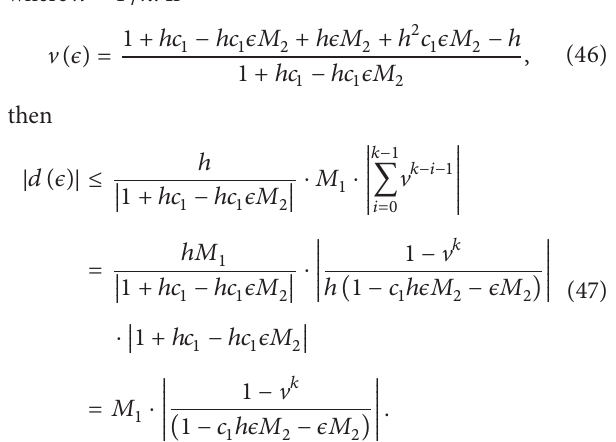
Figure 4: Least 𝑘 for unique periodic solution. The explicit Euler (–– –), linearized implicit midpt (—), and the linearized implicit Euler ( × ×